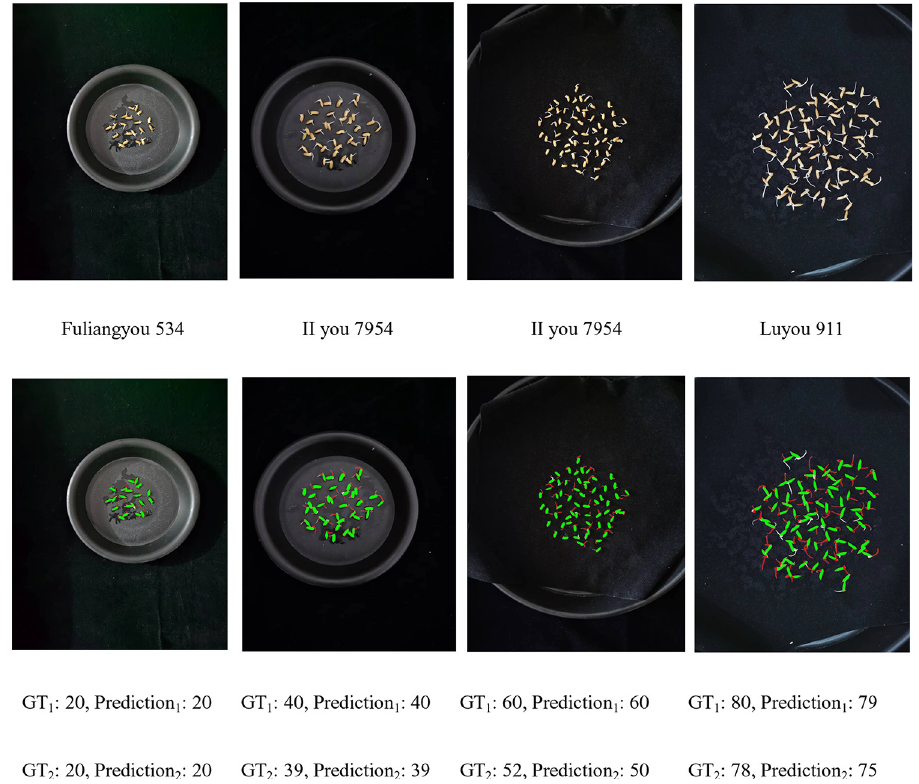
S1 Table. 30 images of Fuliangyou 534 and the germination detection results. S2 Table. 30 images of II you 534 and the germination detection results. S3 Table. 30 images of Luyou 911 and the germination detection